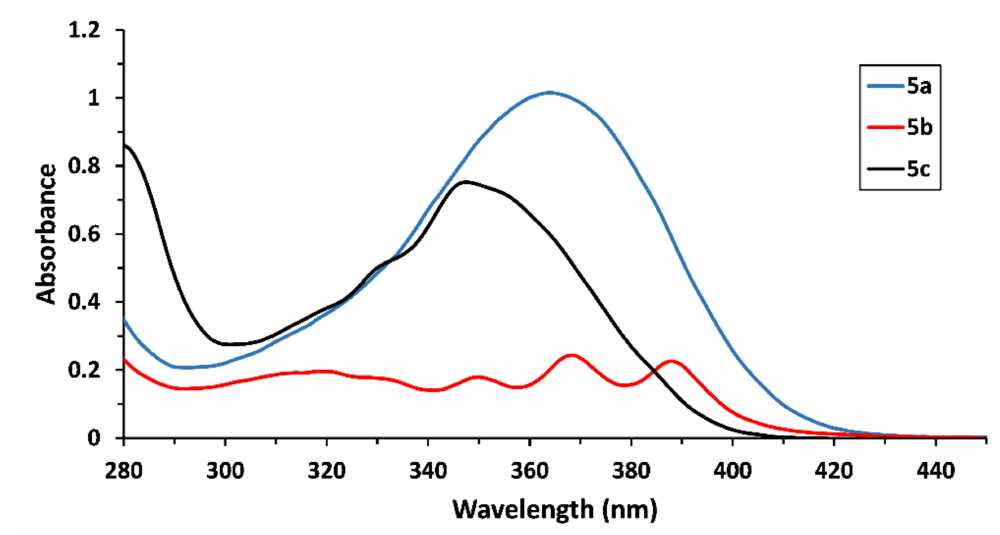
Figure 3. Absorption spectra of 5a–c in DMSO (50 µ M). 5b was only partially dissolved, and 5 µ M concentration was